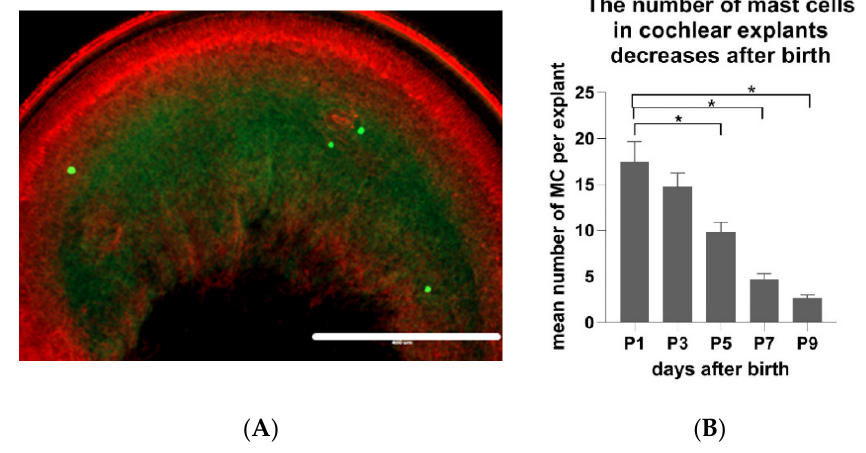
Figure 5. The number of cochlear MCs of Wistar rats decreases during postnatal development (p1–p9). ( A ) An exemplary micrograph of MCs visualized in the flat preparation of cochlear explants with avidin-AlexaFluor ® 488 and phalloidin-Texas red TM (to stain filamentous actin). Scale bar 400 µm. ( B ) Quantification of MC numbers in the flat cochlear preparations of naïve p1–p9 Wistar rats. Presented are the average values, whiskers +/- SD. Significance: * p < 0.01 (one-way ANOVA). Sample size (cochleae): p1 n = 32, p3 n = 32, p5 n = 32, p7 n = 32, p9 n = 32.